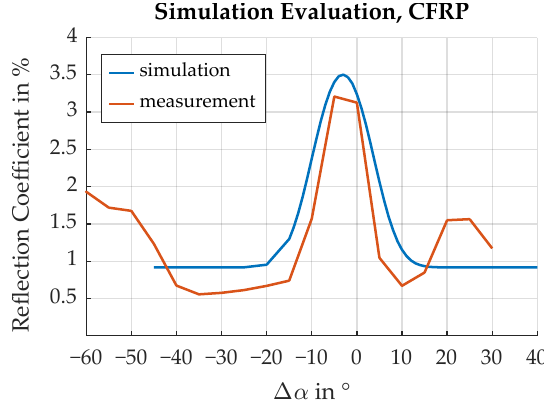
Figure 10. Comparison of the measured surface reflection with the simulated results for CFRP. Incidence angle φ = 45°, emergent angle α =